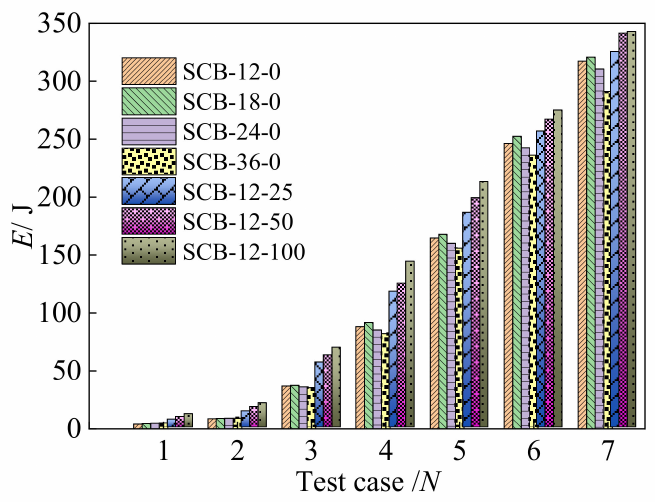
Figure 10. Energy dissipation coefficient of